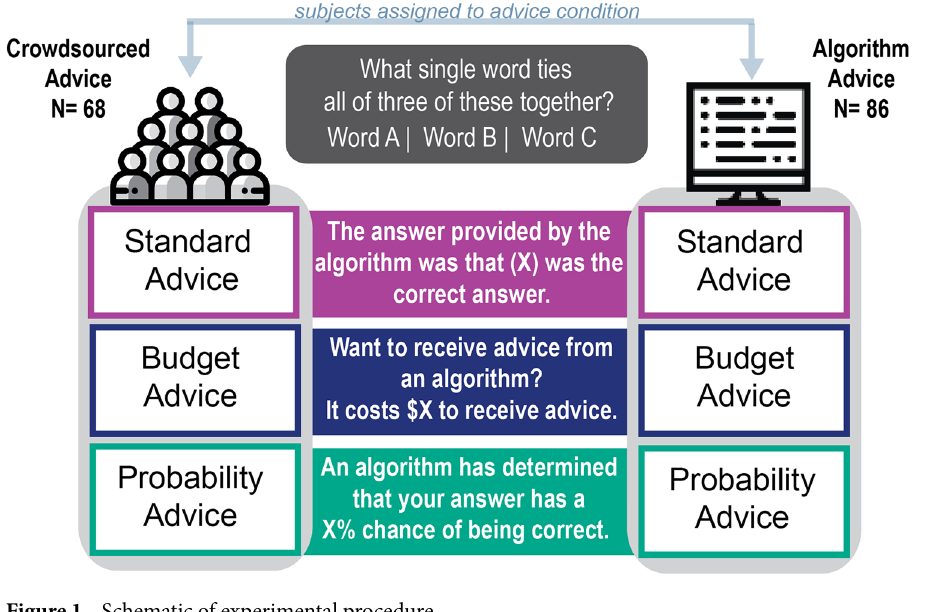
Figure 1. Schematic of experimental procedure.